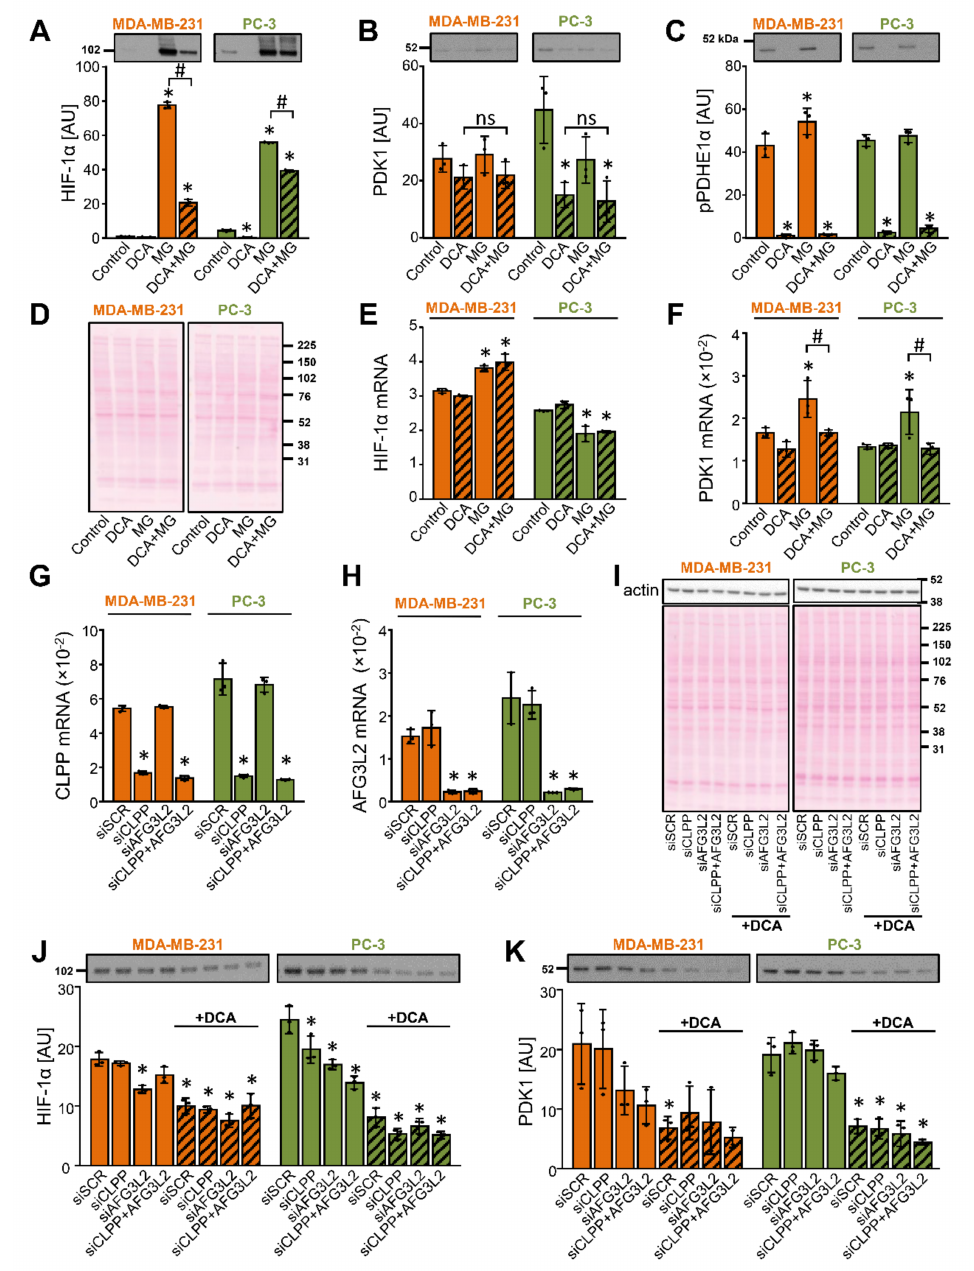
Figure 6. InhibitionoftheproteasomeormitochondrialproteasesdoesnotpreventtheDCA-inducedsuppressionofPDK1inMDA-MB-231andPC-3cells. ( A – F ) Cells were treated with DCA (10 mM) for 12 h in serum-free RPMI medium. MG-132 (10 µ M, MG) was added during the final 6 h. ( G – K ) Cells were transfected with 20 nM scrambled siRNA (siSCR) or 10 nM CLPP and/or AFG3L2 siRNA (siCLPP and siAFG3L2). ( G , H ) Gene expression was assessed 48 h after the transfection. ( J , K ) Cells deficient in CLPP (siCLPP) and/or AFG3L2 (siAFG3L2) and control (siSCR) cells were treated with 10 mM DCA in serum- free RPMI medium for 24 h. The mRNA expression of ( E ) HIF-1 α , ( F ) PDK1, ( G ) CLPP, and ( H ) AFG3L2 was estimated with qPCR (endogenous control: cyclophilin). The abundance of ( A , J ) HIF-1 α , ( B , K ) PDK1, ( C ) phospho-PDHE1 α Ser293 (pPDHE1 α ), and ( I ) β -actin was determined with immunoblotting. ( D , I ) Protein loading was evaluated with the Ponceau S staining. Numbers next to the blots and Ponceau stains indicate molecular weight markers in kDa. Results are means ± SD of one experiment, performed in triplicate, for each cell line and condition ( n = 3). * p < 0.05 vs. Control or siSCR and # p < 0.05 as